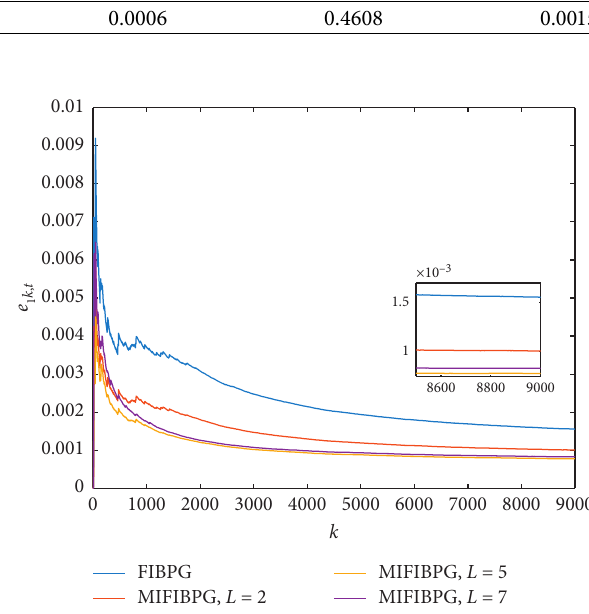
Table 7: Estimation errors for the FSOEAHW model using FIBPG algorithm. FIBPG algorithm